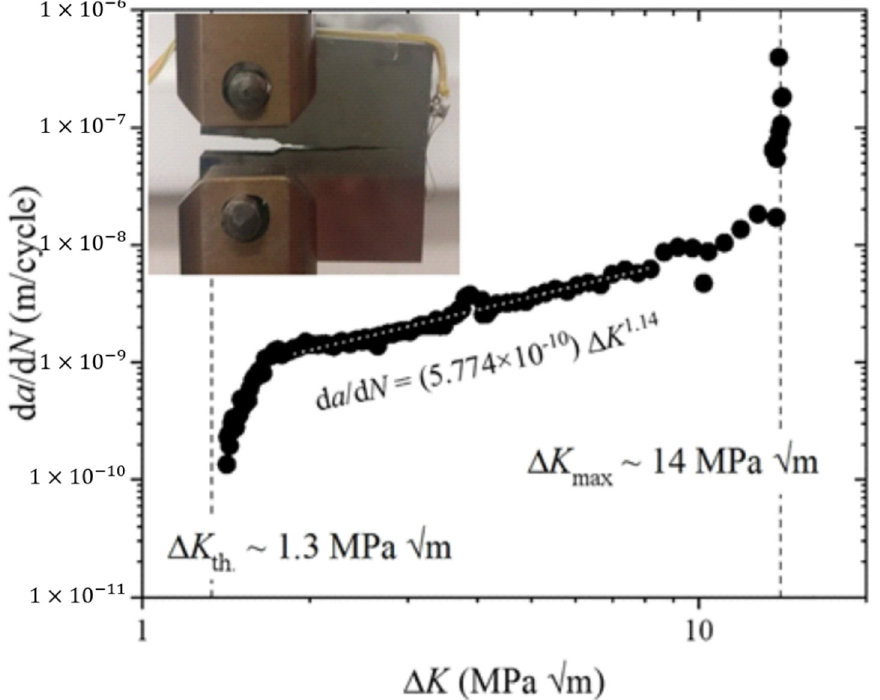
Figure 51. Fatigue crack-growth diagram of AMZ4 fabricated via LPBF. Reproduced from [67], with permission from Elsevier, 2021.